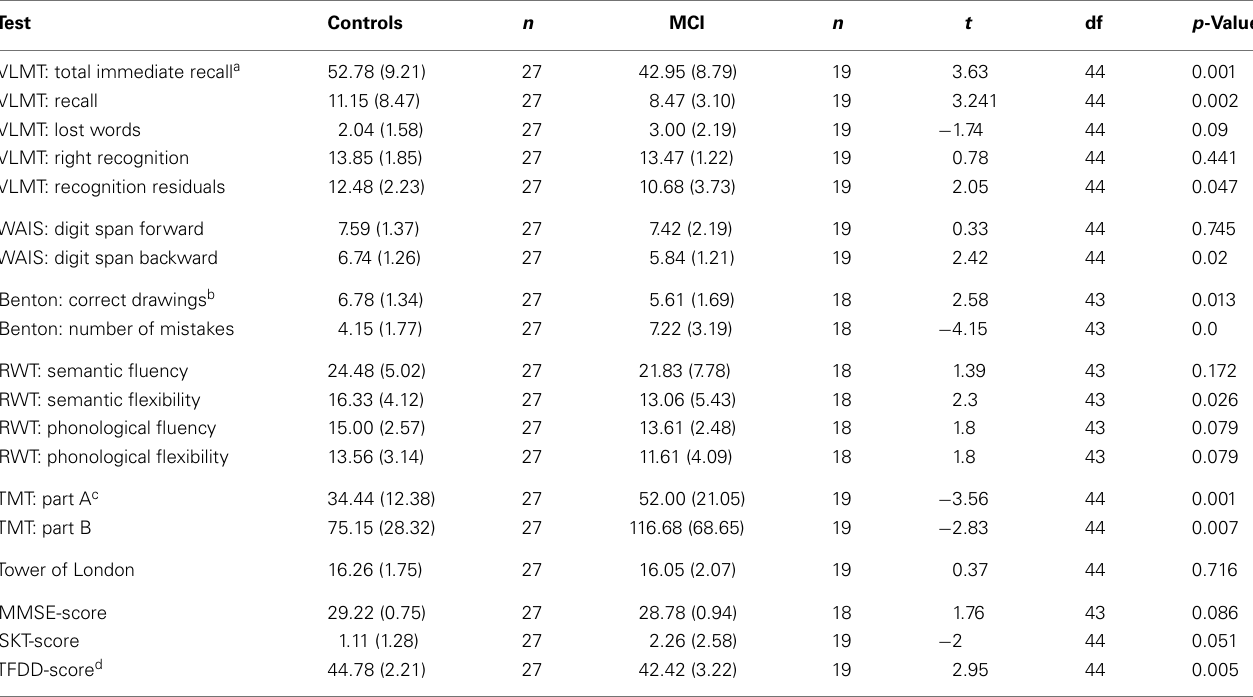
Table 2 | Neuropsychological data .